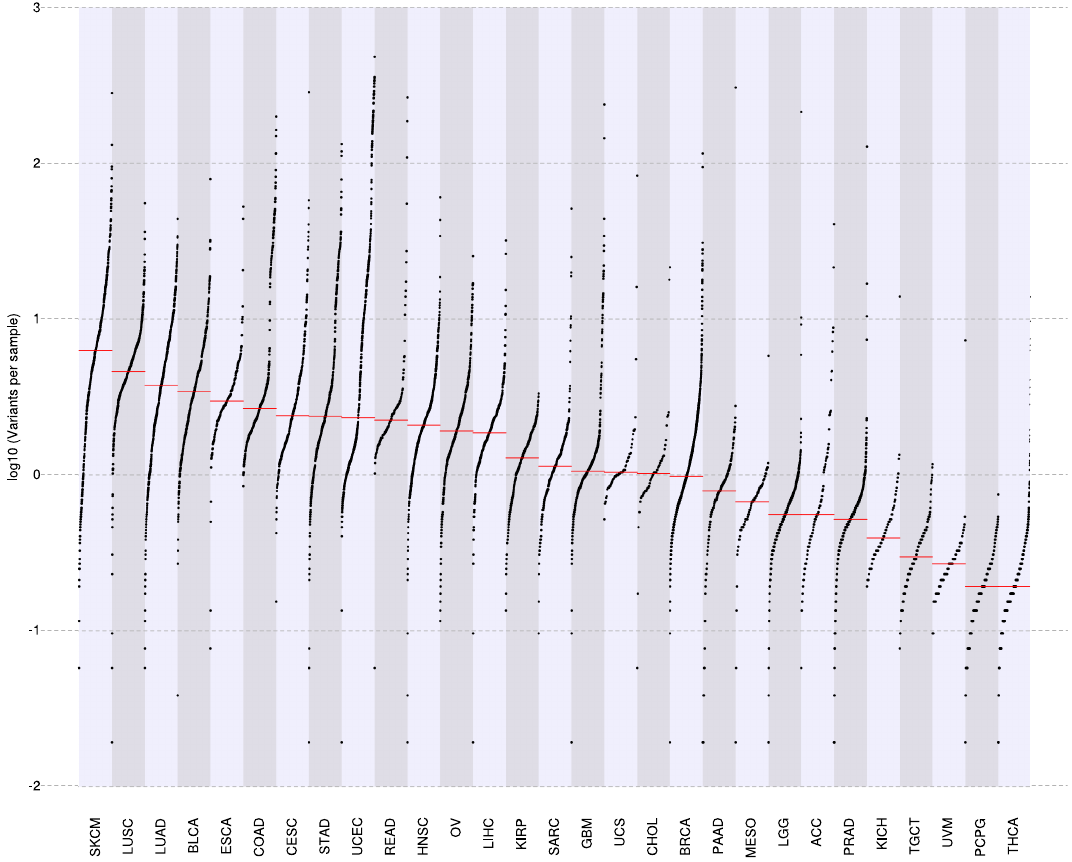
Figure A1. Tumor mutational burden (TMB) calculated for all the cases included in the analysis. Abbreviations of cancer cohort: adrenocortical carcinoma (ACC), bladder urothelial carcinoma (BLCA), breast invasive carcinoma (BRCA), cervical squamous cell carcinoma and endocervical adenocarcinoma (CESC), cholangiocarcinoma (CHOL), colon adenocarcinoma (COAD), esophageal carcinoma (ESCA), glioblastoma multiforme (GBM), head and neck squamous cell carcinoma (HNSC), kidney chromophobe (KICH), kidney renal papillary cell carcinoma (KIRP), brain lower grade glioma (LGG), liver hepatocellular carcinoma (LIHC), lung adenocarcinoma (LUAD), lung squamous cell carcinoma (LUSC), mesothelioma (MESO), ovarian serous cystadenocarcinoma (OV), pancreatic adenocarcinoma (PAAD), pheochromocytoma and paraganglioma (PCPG), prostate adenocarcinoma (PRAD), rectum adenocarcinoma (READ), sarcoma (SARC), skin cutaneous melanoma (SKCM), stomach adenocarcinoma (STAD), testicular germ cell tumors (TGCT), thyroid carcinoma (THCA), uterine corpus endometrial carcinoma (UCEC), uterine carcinosarcoma (UCS) and uveal melanoma